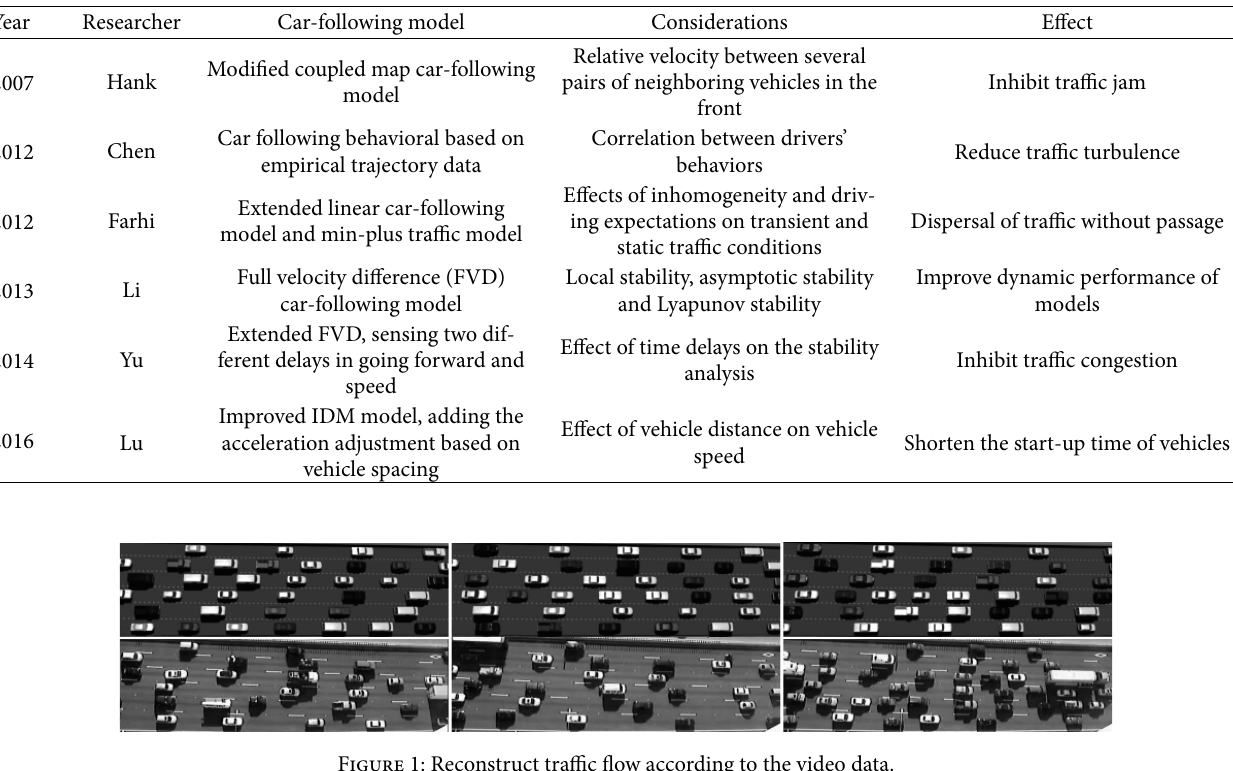
Table 1: Comparative analysis of various car following technologies.